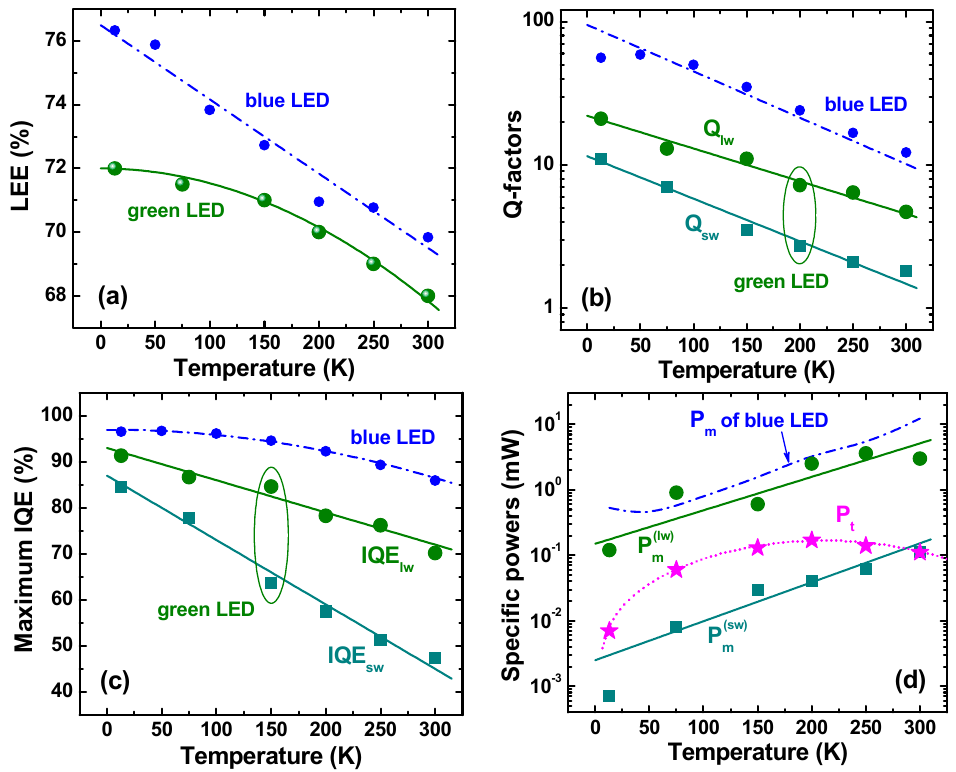
Figure 6. Light extraction efficiency ( a ); quality factors corresponding to lower-wavelength ( Q lw ) and shorter-wavelength ( Q sw ) spectral peaks ( b ); Maximum internal quantum efficiency ( c ); and specific optical power (see text for more detail) as a function of temperature given by big symbols ( d ). Dash-dotted lines and small circles show for comparison similar data reported earlier for blue LEDs [5]. Solid and dotted lines in the plots are drawn for eye.